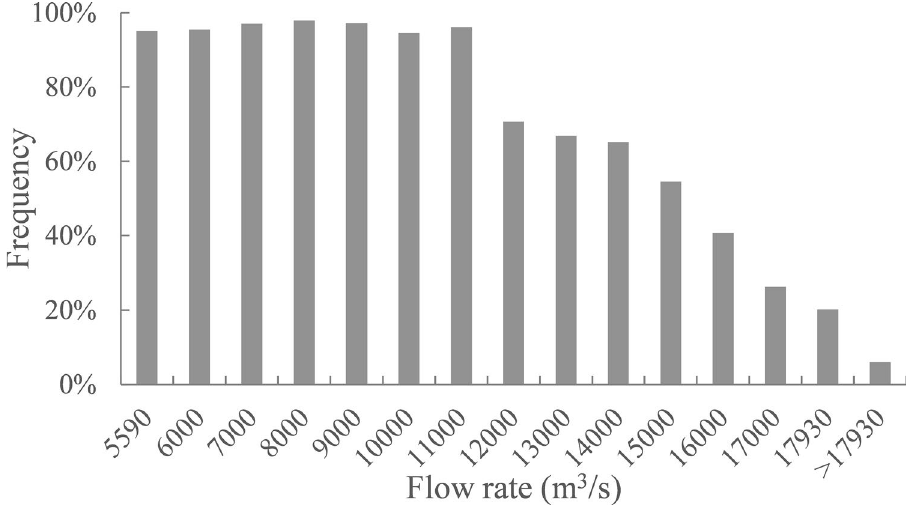
Figure 4. Proportions of the suitable-velocity area with all units opened under different discharges.